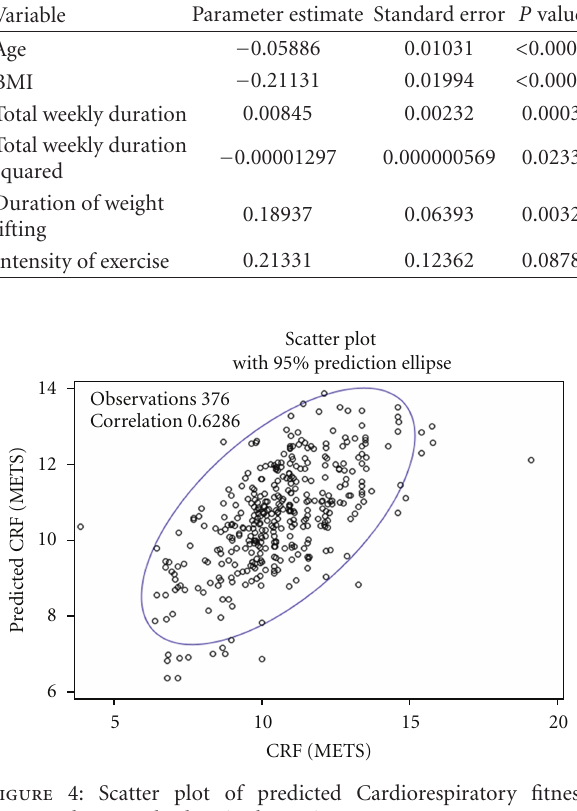
Figure 4: Scatter plot of predicted Cardiorespiratory fitness compared to actual values in the testing set.